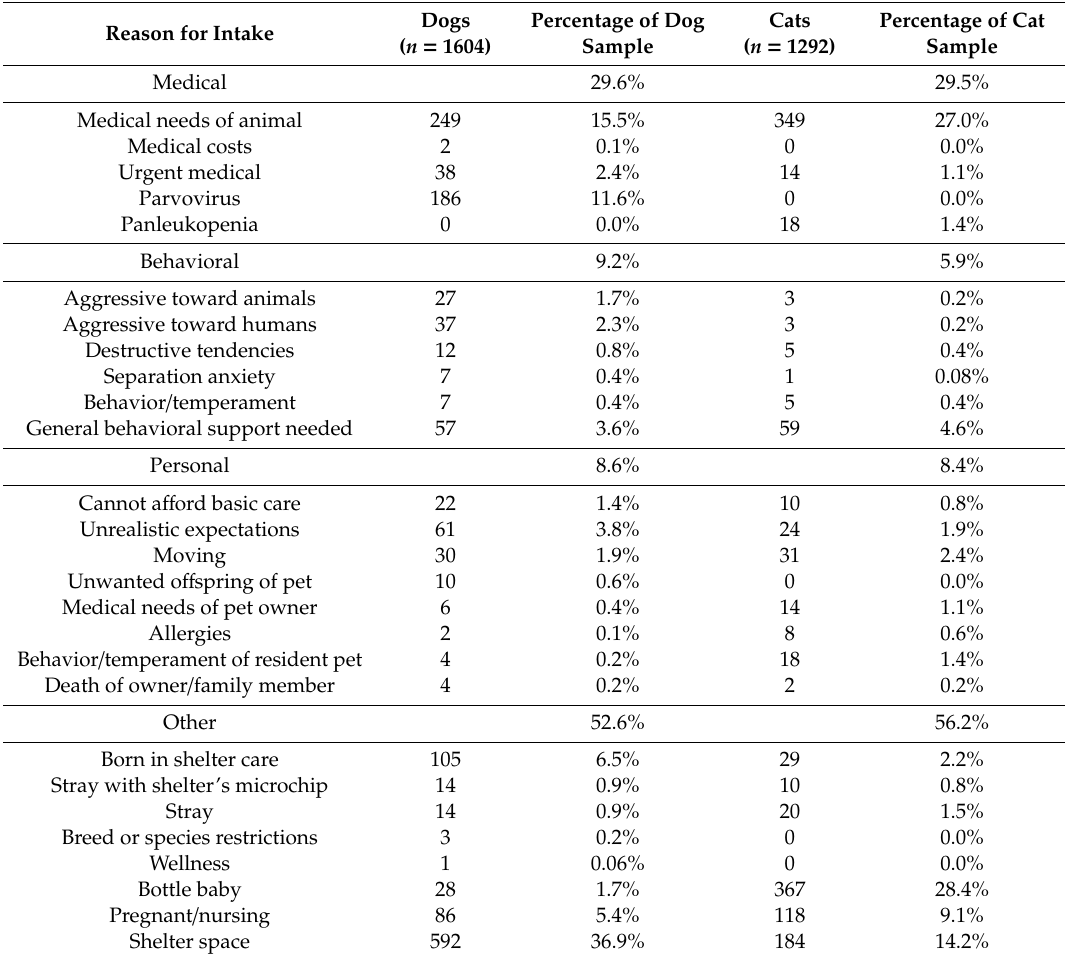
Table 1. Reasons for intake of all dogs ( n = 1604) and all cats ( n = 1292) who came into the care